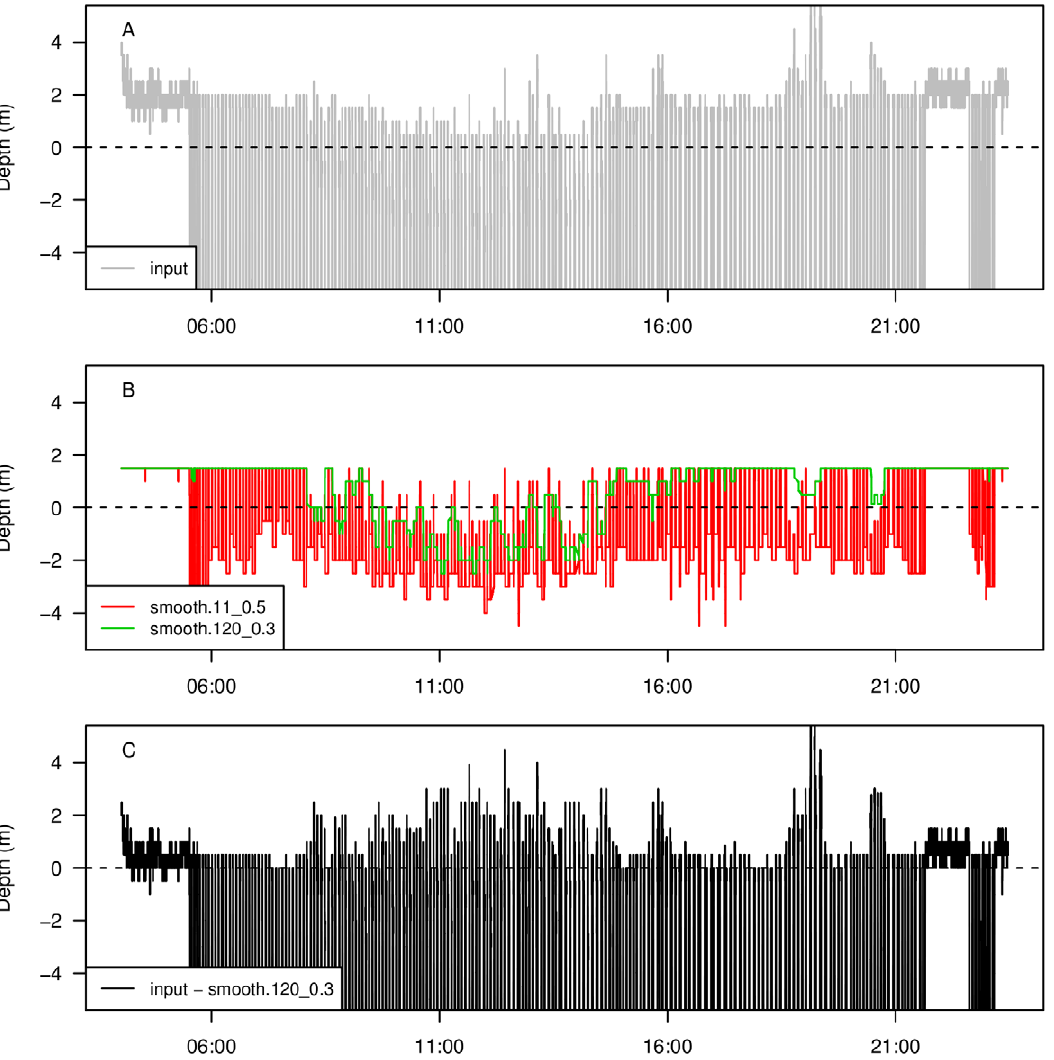
Figure 6. Zero offset correction of TDR data from a king penguin. Input time series (A), first filter (median) using a moving window of size 11 (11 s) and second filter (0.3 quantile) using moving window of size 120 (120 s) (B), and corrected depth (input series minus last filter) (C). The y-axis limits are restricted to be approximately equal to the range of surface depth in the time series for clarity.